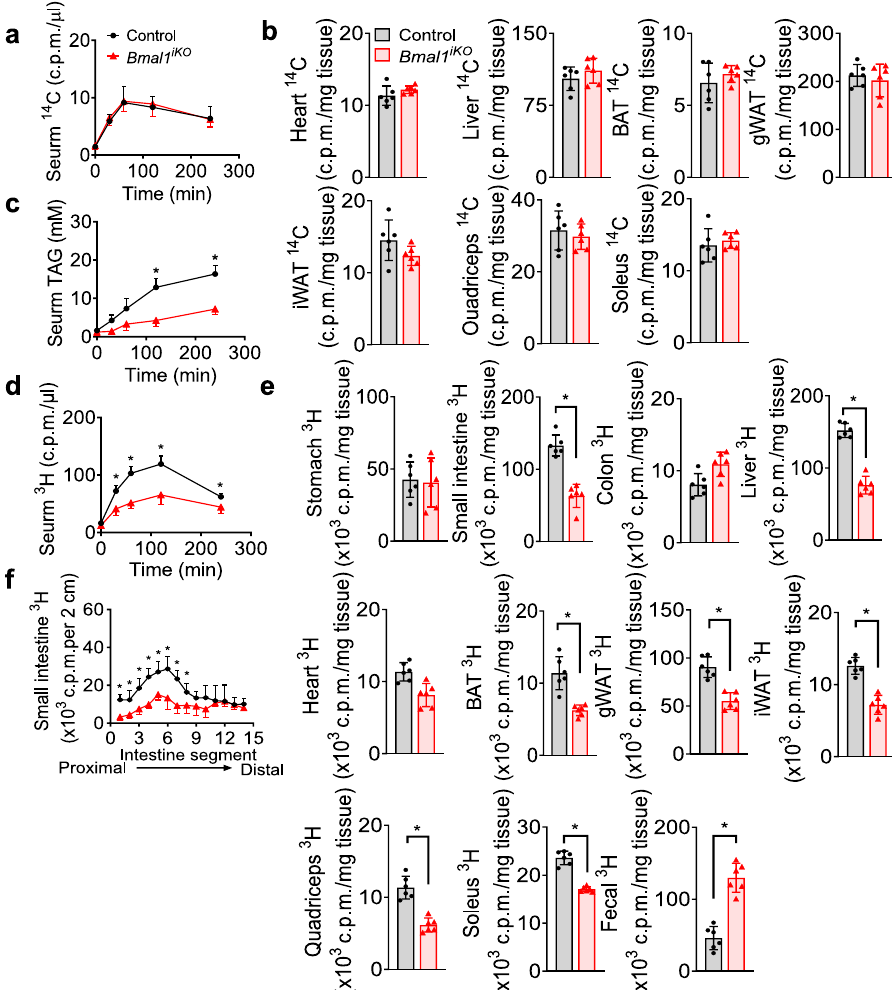
Fig. 4 Impaired intestinal lipid secretion in Bmal1 iKO mice. a Serum 14 C radioactivities in Bmal1 iKO and control mice after i.p. injection of [ 14 C]-oleic acid. b 14 C radioactivities in the tissues of Bmal1 iKO and control mice at 2 h after i.p. injection of [ 14 C]-oleic acid. c Serum TAG levels in tyloxapol (500 mg/kg, i.p., 30 min)-pretreated Bmal1 iKO and control mice after olive oil gavage (10 μ l/g). p values (from left to right): 0.3179, 0.0019, 0.0106, < 0.0001 and <0.0001 (two-way ANOVA and Bonferroni post hoc test). d Serum 3 H-radioactivities in Bmal1 iKO and control mice after gavage of [ 3 H]-triolein. p values (from left to right): 0.0716, 0.0004, <0.0001, <0.0001 and 0.0059 (two-way ANOVA and Bonferroni post hoc test). e 3 H-radioactivities in the tissues and feces of Bmal1 iKO and control mice at 2 h after gavage of [ 3 H]-triolein. Two-sided t test p values: 0.8101 (stomach), <0.0001 (small intestine), 0.0594 (colon), <0.0001 (liver), 0.0511 (heart), 0.0004 (BAT), <0.0001 (gWAT), <0.0001 (iWAT), <0.0001 (quadriceps), <0.0001 (soleus) and <0.0001 (feces). f Distribution of dietary TAG in the small intestine of Bmal1 iKO and control mice at 2 h after gavage of [ 3 H]-triolein. p values (from left to right): <0.0001, 0.0040, 0.0009, <0.0001, 0.0008, 0.0015, 0.0002, 0.0246, 0.0895, 0.0842, 0.6833, 0.9999, 0.9278 and 0.1319 (two-way ANOVA